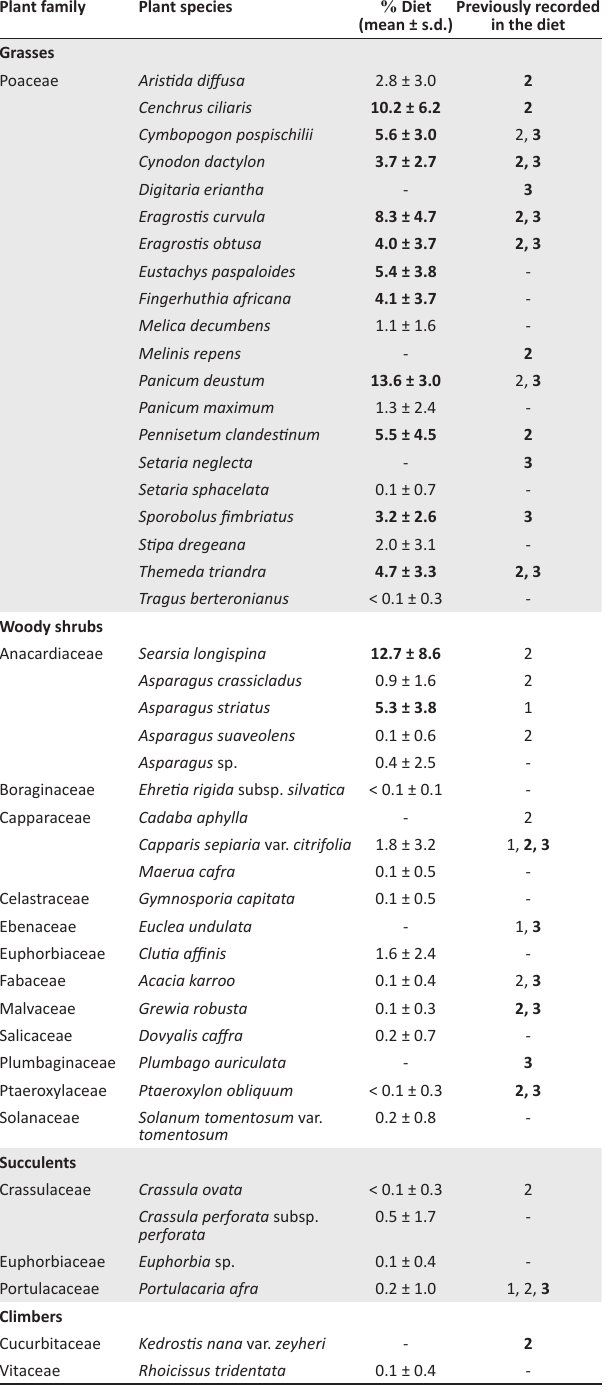
s.d.)Previously recorded (mean ± in the diet